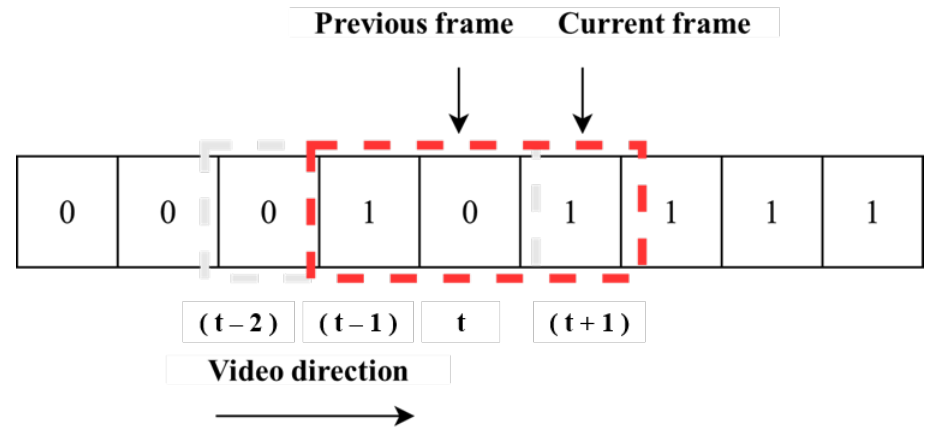
Figure 4. Sliding window concept.